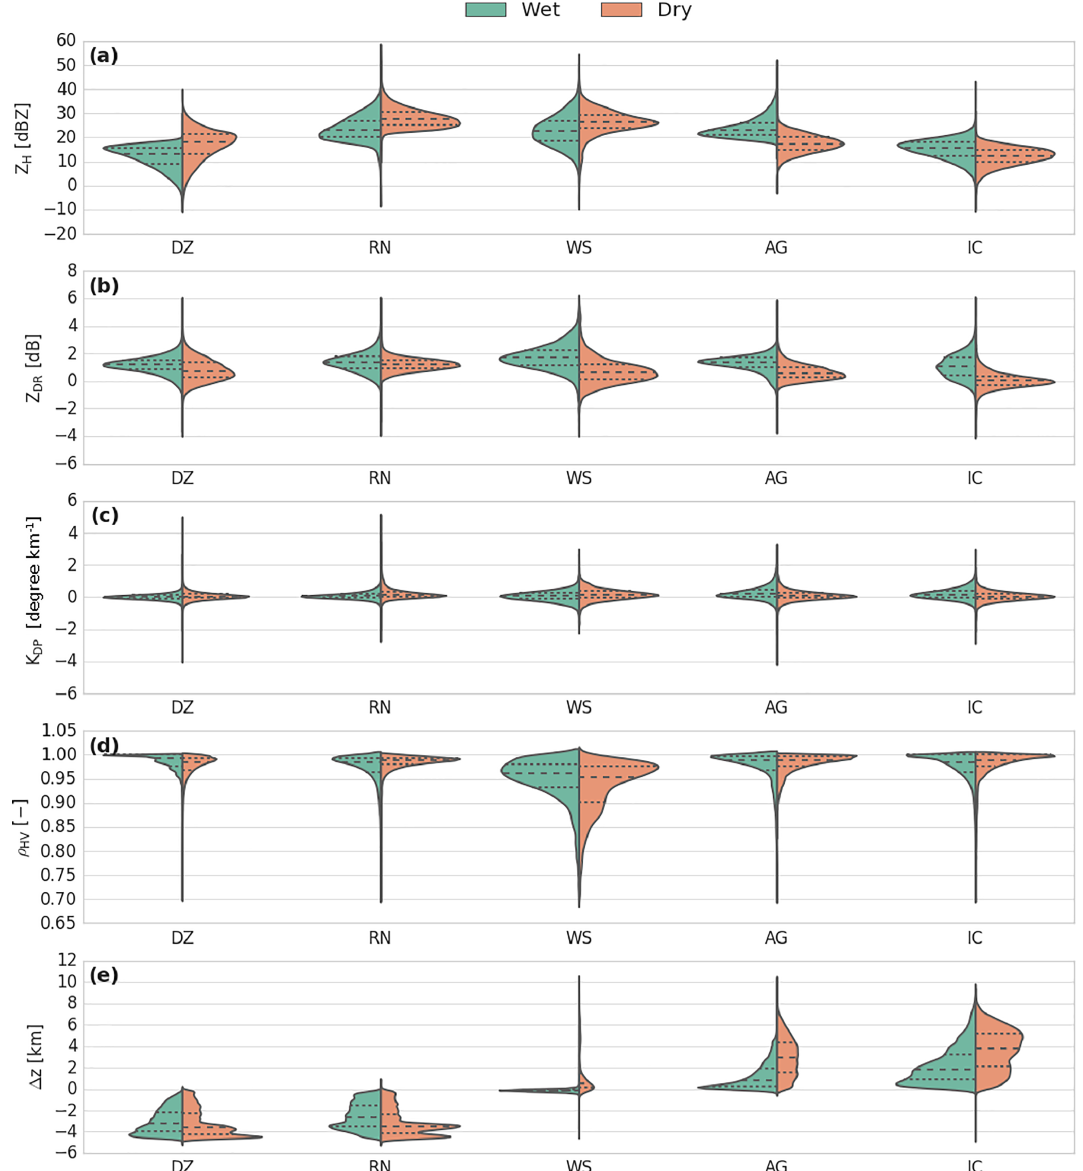
Figure 13. Violin plot comparison of pairs of stratiform hydrometeor types between the wet and dry seasons (DZ is drizzle, RN is rain, WS is wet snow, AG is aggregates, and IC is ice